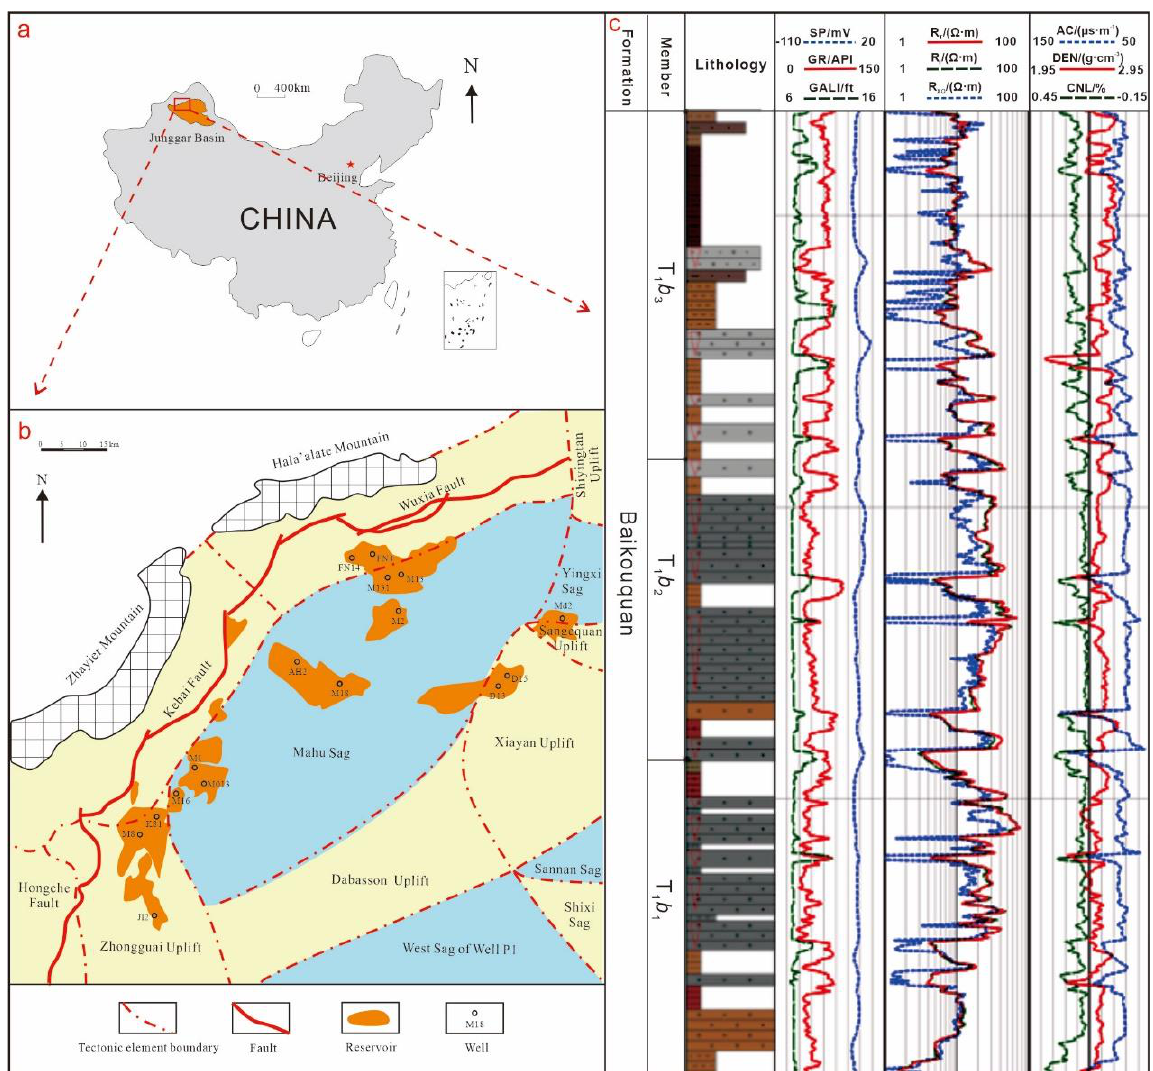
Figure 1. Geological background map of Mahu Sag; ( a ) location of the Junggar Basin; ( b ) structural map of Mahu Sag; ( c ) lithology and logging curve of Baikouquan Formation [24].